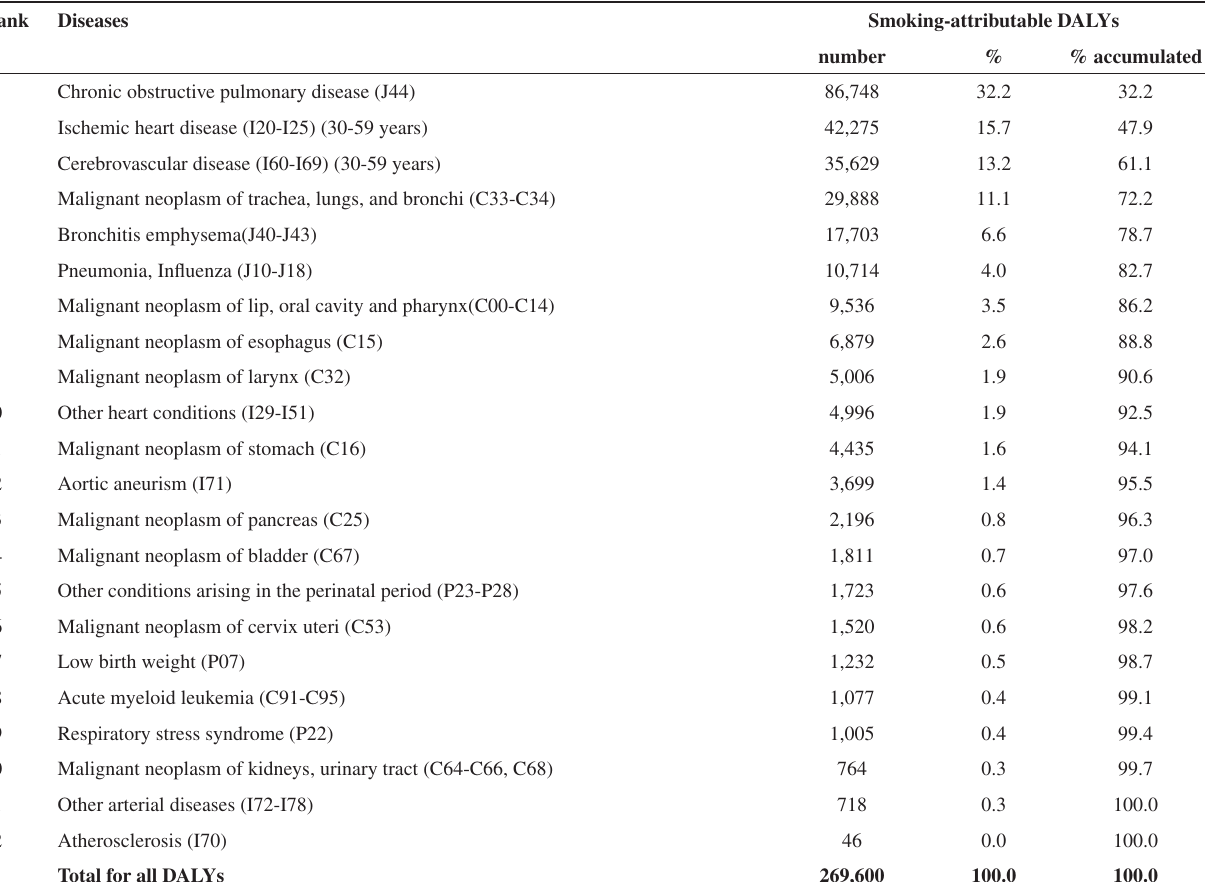
Table 3 - Smoking-attributable DALYs, proportional distribution, and accumulated proportional distribution according to diseases in individuals 30 years and older. Rio de Janeiro State, Brazil, 2000